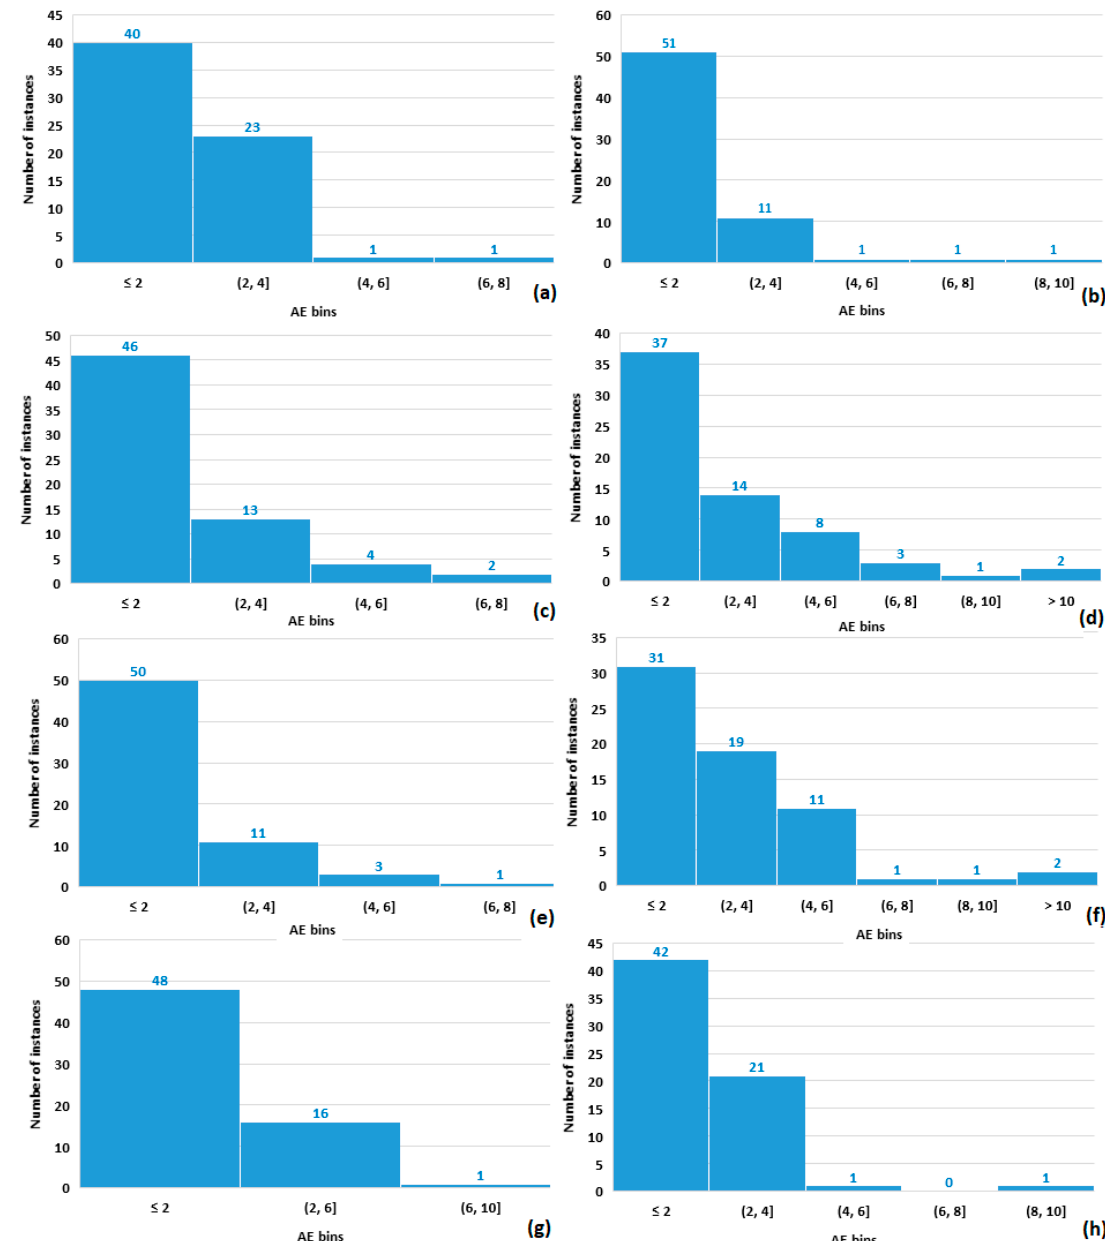
Figure 10. Absolute Error (AE) distribution for ( a ) Elman Neural Network—ENN, ( b ) Feed-Forward Neural Network—FFNN, ( c ) Group Method of Data Handling—GMDH, ( d ) General Regression Neural Network—GRNN, ( e ) LSTM-ENN, ( f ) Radial Basis Function—RBF, ( g ) Relevant Vector Machine—RVM, and ( h ) Support Vector Regression—SVR for Test Case #1.